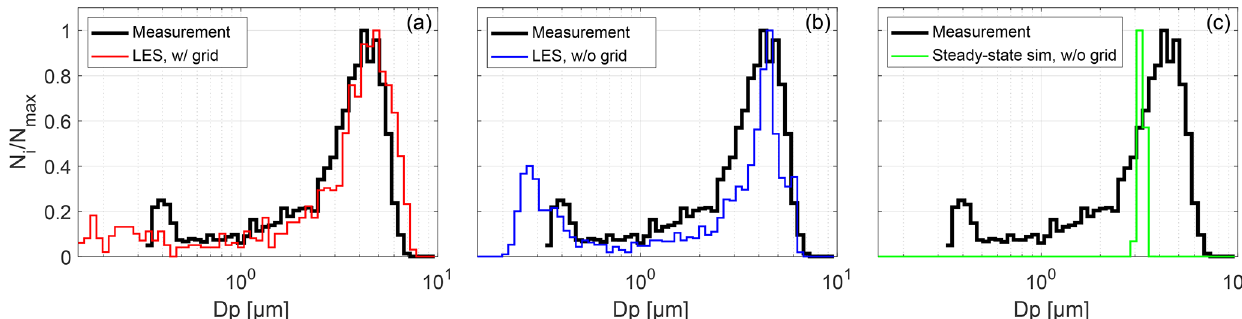
Figure 13. Comparison between different model calculations for the particle formation and growth on NaCl particles with D p , dry = 100nm at z 8 for (cid:49)T = 16K. (a) LES with turbulence grid (as shown in (c) of Fig. 12). (b) LES but without turbulence grid. (c) Simulation with averaged fields used as frozen flow fields, and transient particle calculation. In all plots, the measurement results, for which the turbulence grid is included (as shown in (c) of Fig. 12), are shown for